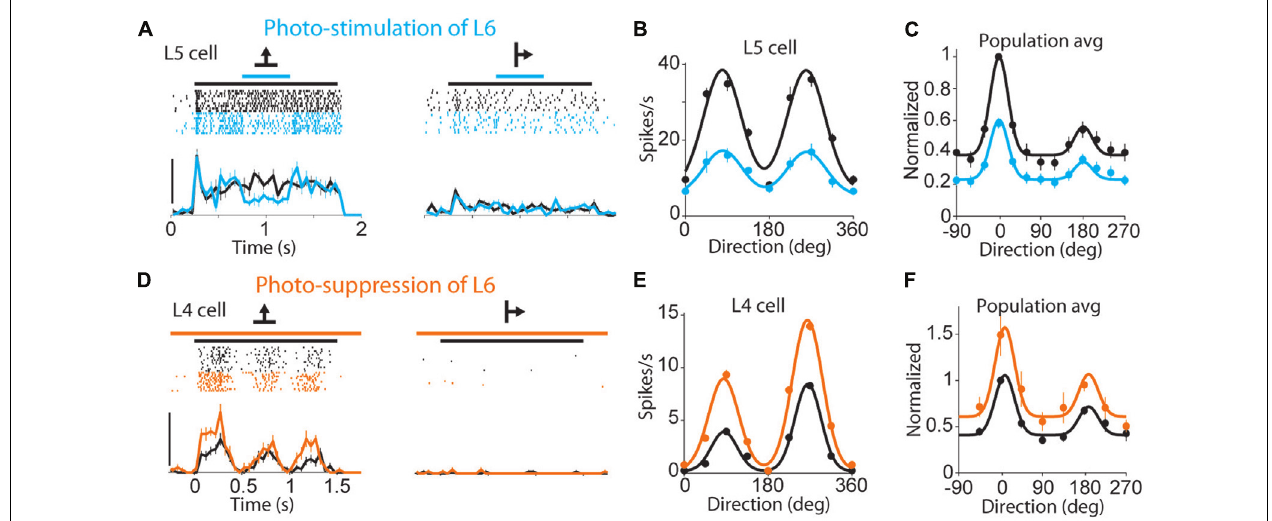
without (black) photostimulation of layerVI; the population tuning curve was generated by first circularly shifting the stimulus direction for each unit so that the maximal response occurred at 0 ◦ .The responses were then normalized to this peak response and averaged ( n = 55 units). (D–F) same as (A–C) but during photosuppression of layerVI, and using a cell from layer IV as example; scale bar in (D) 50 spikes/s; population tuning curve in (F) is the average of n = 52 units. (Reprinted from Olsen etal., 2012, with permission from Macmillan